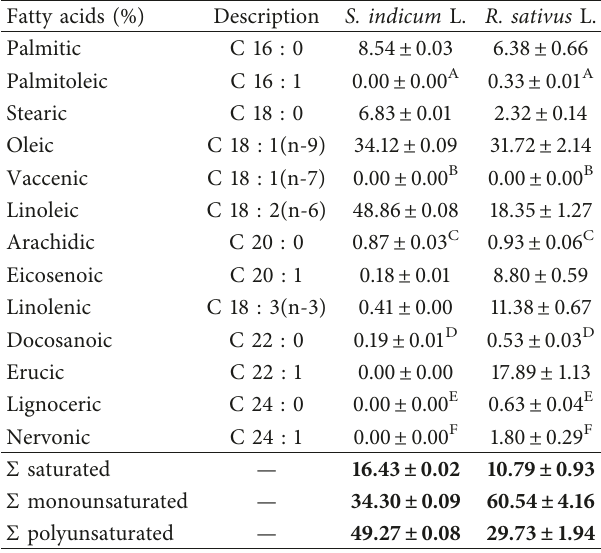
Table 1: Fatty acid methyl ester composition in biodiesels from Sesamum indicum L. and Raphanus sativus L. [16].